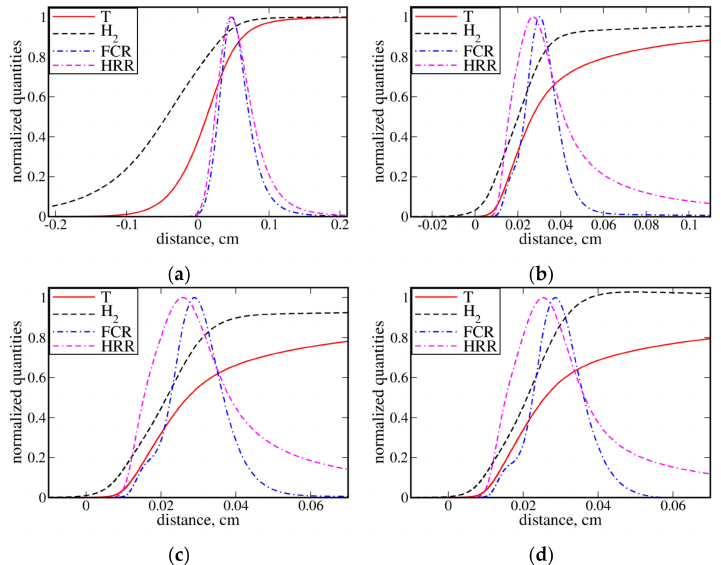
Figure 1. Profiles of c T , c F , fuel consumption rate, and heat release rate, normalized using their peak values. The profiles have been obtained from unperturbed hydrogen–air premixed flames characterized by different equivalence ratios: ( a ) φ = 0.35, ( b ) φ = 0.8, ( c ) φ = 1.0, and ( d ) φ =